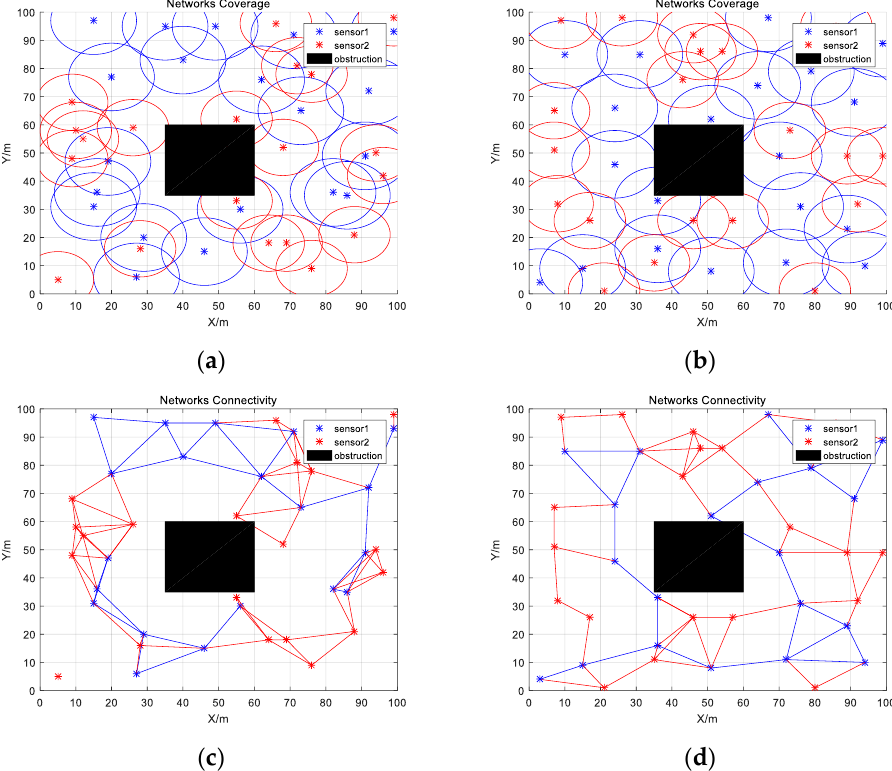
Figure 9. Obstacle coverage and connectivity map of sensors. ( a ) Initial obstacle coverage map of sensors; ( b ) Optimized obstacle coverage map of sensors; ( c ) Initial obstacle connectivity map of sensors; ( d ) Optimized obstacle connectivity map of sensors. Table 17. Comparison of HWSN obstacle coverage optimization experimental results.